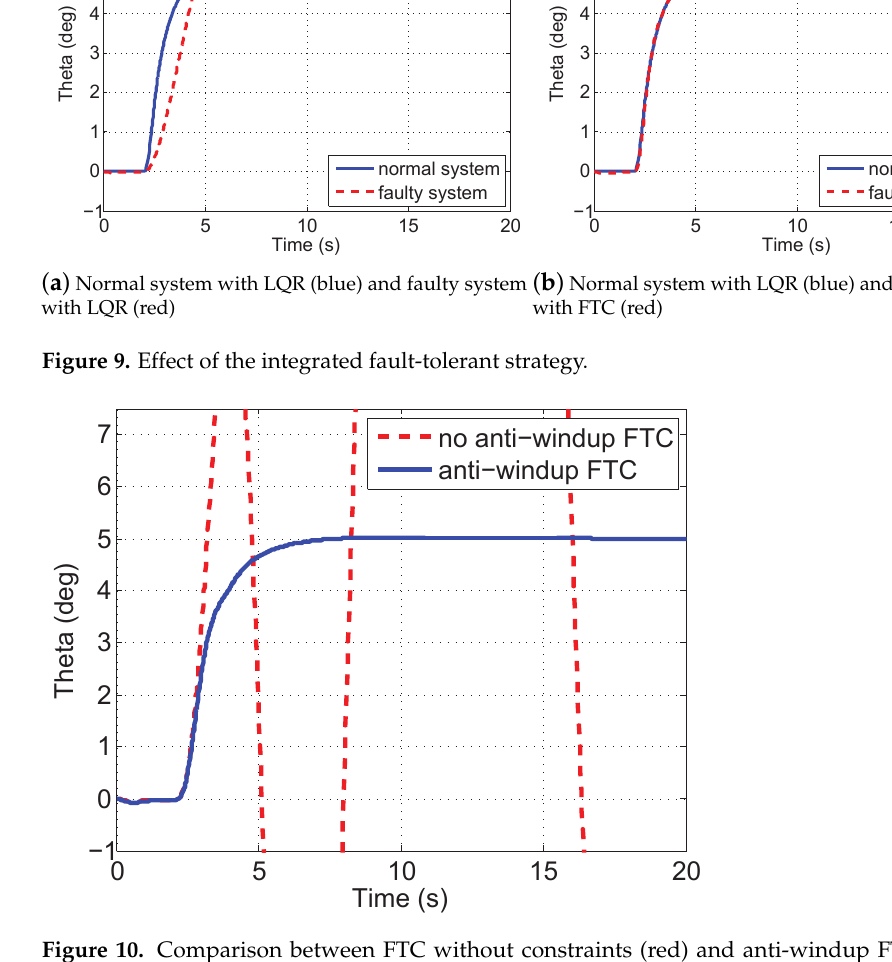
Figure 10. Comparison between FTC without constraints (red) and anti-windup FTC with con- straints (blue).